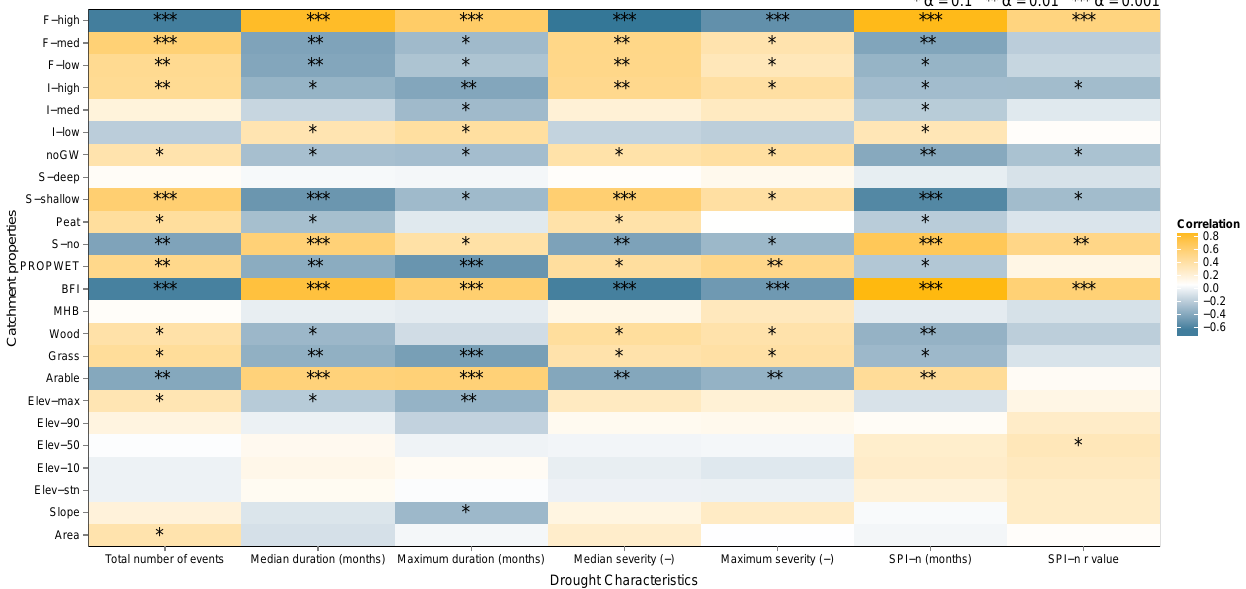
Figure 13. Heat map showing the correlations between selected hydrological drought characteristics based on SSI-1 using a threshold of − 1 and catchment properties for catchments in clusters three and four. See Table 1 for descriptions of the catchment properties.